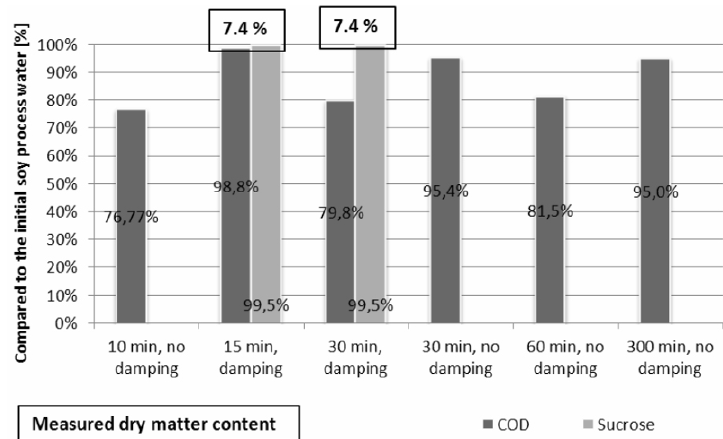
Figure 3. Comparison of clarified liquid and residue ratio in the centrifugal separation experiments.